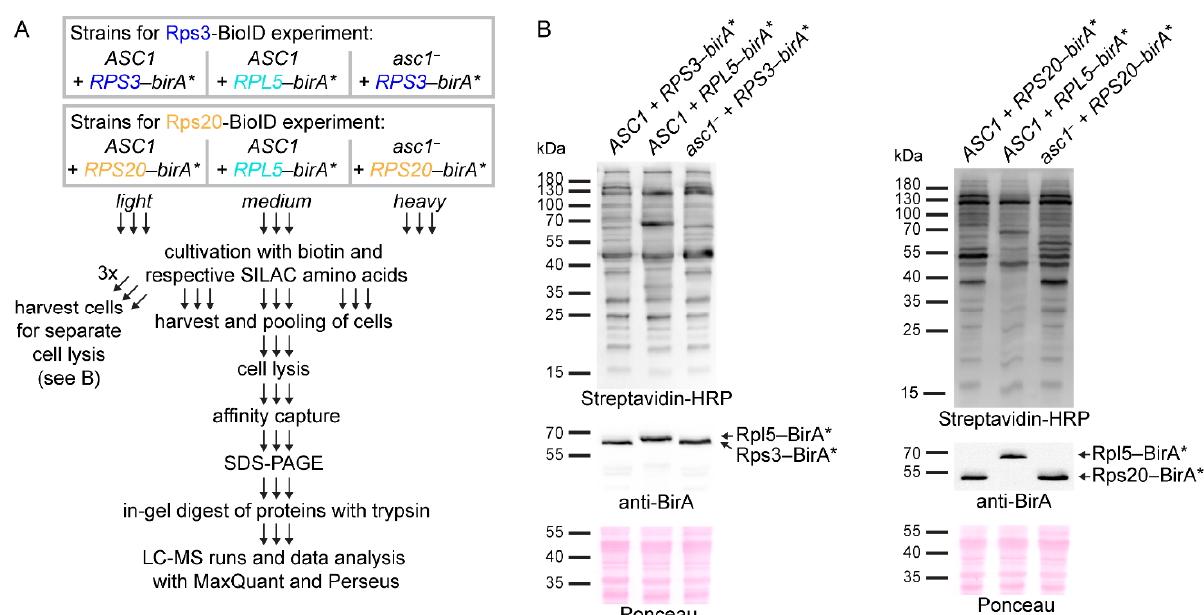
Figure 2. Workflow of the Rps3 and Rps20 proximity labeling MS experiments. ( A ) For the Rps3-BioID experiment, ASC1 wild-type and asc1 − strains (RH3493 and RH3520, respectively) expressing plasmid-borne Rps3-BirA* were cultivated with light and heavy SILAC amino acids, respectively. As a negative control, an ASC1 wild-type strain expressing Rpl5-BirA* was labeled with the medium SILAC amino acids. Equivalently, the Rps20-BioID experiment was performed using strains expressing Rps20-BirA* instead of Rps3-BirA*. Cells were cultivated in the presence of the respective SILAC amino acids and with 10 µM biotin. Cells of the individual cultures were harvested in the exponential growth phase and combined. An aliquot of the still separate cell cultures was taken for cell lysis for the Western blot experiments depicted in ( B ). The protein extracts of the pooled cells were used to enrich biotinylated proteins via affinity purification. Proteins were subjected to SDS-PAGE followed by in-gel digestion with trypsin. Peptides were analyzed with LC-MS, and data analysis was performed using the MaxQuant and Perseus software. ( B ) Cell lysates of the indicated strains were separated by SDS-PAGE and proteins transferred onto nitrocellulose membranes to detect RP-BirA* fusion proteins and biotinylated proteins using a BirA-specific antibody and Streptavidin-HRP, respectively. One of three replicates is shown representatively.